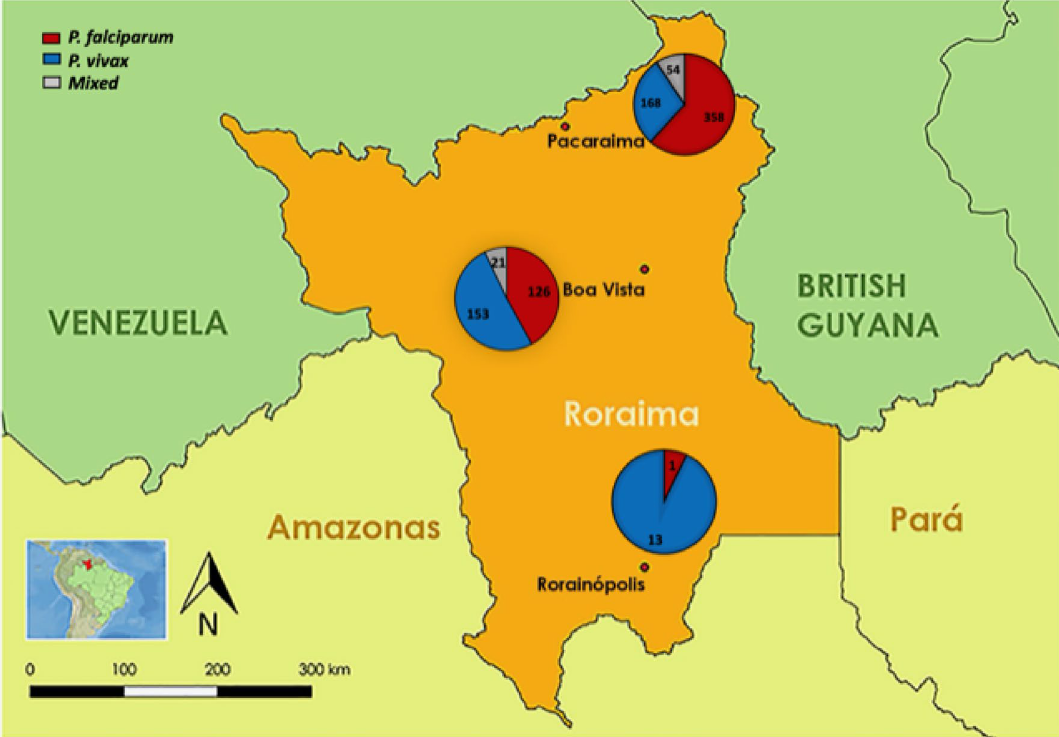
Figure 1. A map of Roraima state and the distribution of malaria cases by species in the municipalities of Pacaraima, Boa Vista and Rorainópolis. The study was carried out in three municipalities in Roraima state: Pacaraima, Boa Vista and Rorainópolis. The distribution of Plasmodium species in the three study sites is shown using different pie-charts for each site. Mixed infections were only observed in Boa vista (21 P. falciparum/P. vivax ) and Pacaraima (53 P. falciparum/P. vivax and 2 P. falciparum/P. ovale ). The map was created in Quantum GIS software (https:// www. qgis. org, QGIS version 2.14.17), using shapefile layers from South America and